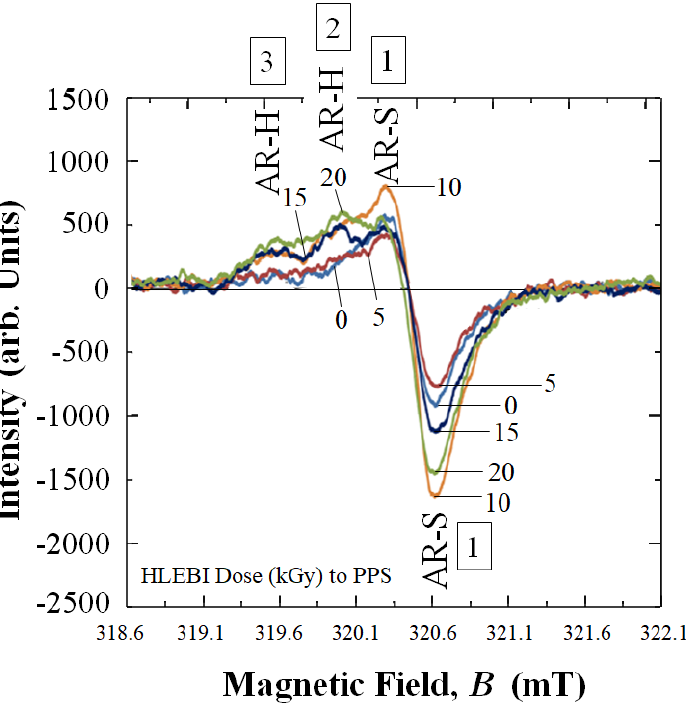
Table 2. Summary of the effect of the HLEBI dose on ESR signal intensities in PPS and a uc at P f = 0.50 of the [PPS] 4 [CF] 3 composite. BDE values of AR - S and AR - H (kJmol −1 ) from [21 , 22] are shown.